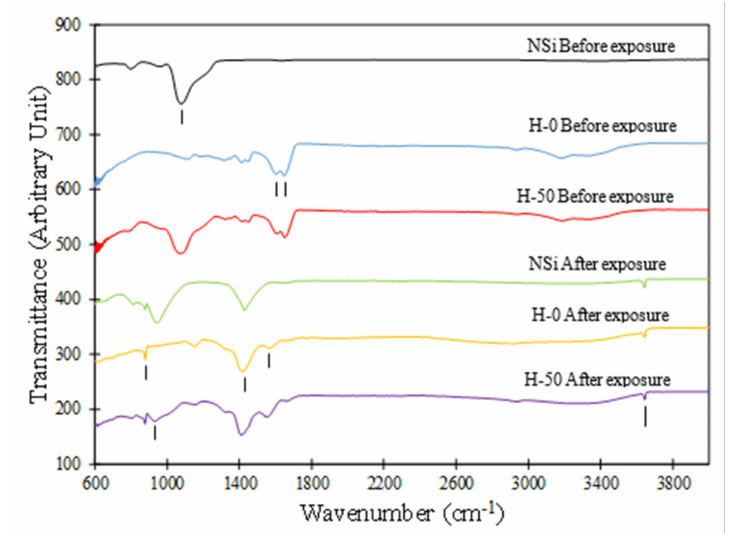
Figure 11. FTIR spectra of NSi, H-0, and H-50 before and after exposure to the lime solution with increased